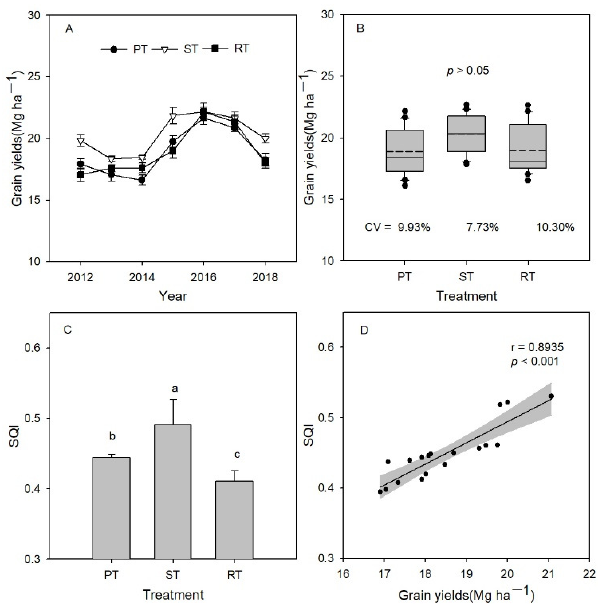
Figure 3. Grain yield and SQI for three tillage managements. ( A ) variation grain yields under three tillage management methods from 2012 to 2018. ( B ) Boxplots of gain yield under three tillage man- agement methods. In each boxplot, the uppermost and lowermost line segments represent the max- imum and minimum values of data, respectively. The central rectangle extends from the first to third quartile (percentiles 25 and 75). In the middle of the boxplot, the line segments represent the median of data, and the imaginary line represents the mean value. In addition, the top and bottom solid points in the boxplot represent the extreme values in the sample data. CV is variable coefficient of each treatment. p is intergroup significance. ( C ) Soil quality index (SQI) results for three tillage management methods. Different small letters in the same color mean significant difference at the 0.05 level. ( D ) The correlation between grain yields and SQI. The line segments represent correla- tion, and the gray area represents 95% confidence level. r is coefficient of association, and p is sig- nificance level of correlation coefficient. PT, plow tillage; ST, subsoiling tillage; RT, rotary tillage. 3.4. Sensitive Indicators The sensitive indicators of different tillage managements differed different (Figure S1). Vectors of SOC, TN, TP, AK, AP and BD went in the same direction as the vector of ST; the vector of SWC was in opposite direction, while the vector of TK was nearly per- pendicular. Thus, the SOC, TN, TP, AK, AP and BD were ST positive sensitive indicators, and the SWC was a restrictive sensitive indicator. Vectors of SWC, TN, TP and BD were in the same direction as the vector of PT, and the vector of SWC and TK were in opposite directions, while the vector of AK and AP were nearly perpendicular. Thus, the SWC and TK were restrictive sensitive indicators for PT, and the SOC, TN, TP and BD were PT pos- itive sensitive indicators. Vectors of SWC and TK were in the same direction as the vector of RT, and the vectors of SOC, TN, TP and BD were in opposite directions, while the vector of AK and AP were nearly perpendicular. Thus, the SOC, TN, TP and BD were RT restric- tive sensitive indicators, and the SWC and TK were positive sensitive indicators. 4. Discussion The spatio-temporal variation of soil properties was related to cropland management [3–5]. Meanwhile, the long-term tillage management experiment provides valuable in- sights into the processes contributing to changes in soil quality [29]. In the present study,